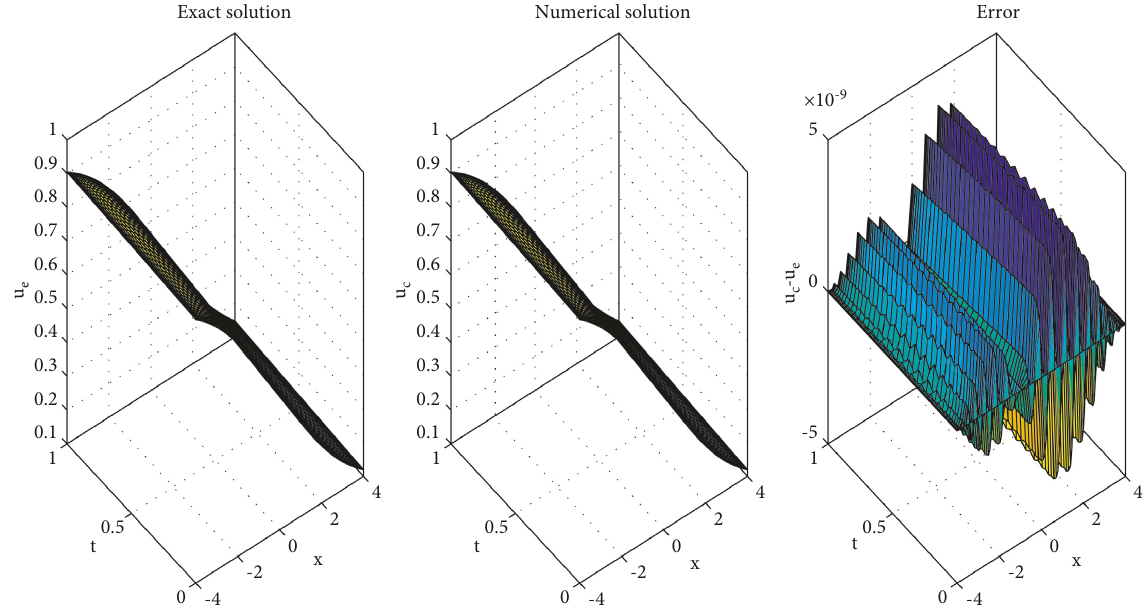
Figure 1: Exact solution, numerical solution, and error of Example 1 ( m � n � 40 ,d Table 6: Errors and convergence rates in the case of equidistant nodes with time interpolation parameter d